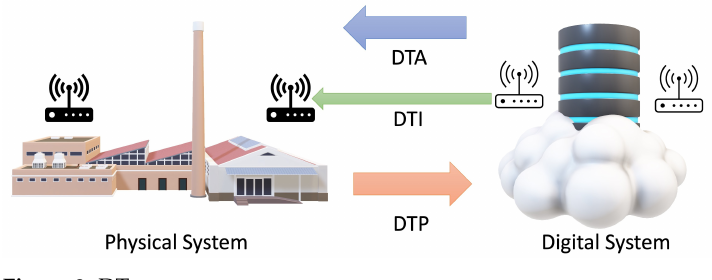
Figure 3. DT types.